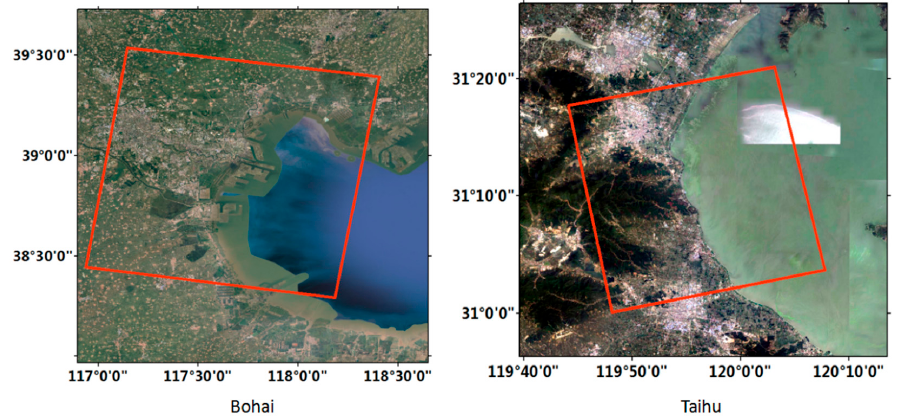
Figure 1. Experimental sites and their specific locations in China. Red box indicates the coverage of the used Sentinel-1 data.